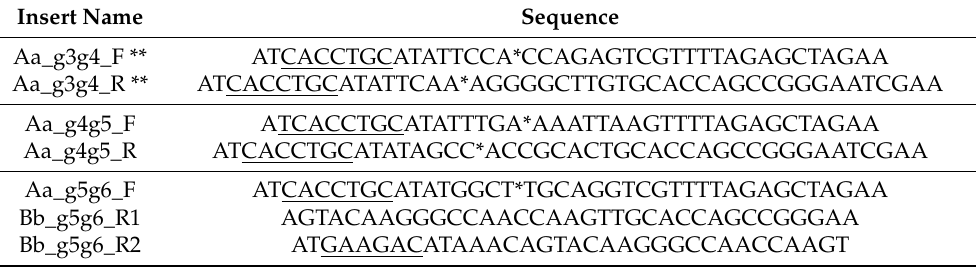
Table 17. Additional list of primers for pBAtC_6sg insert